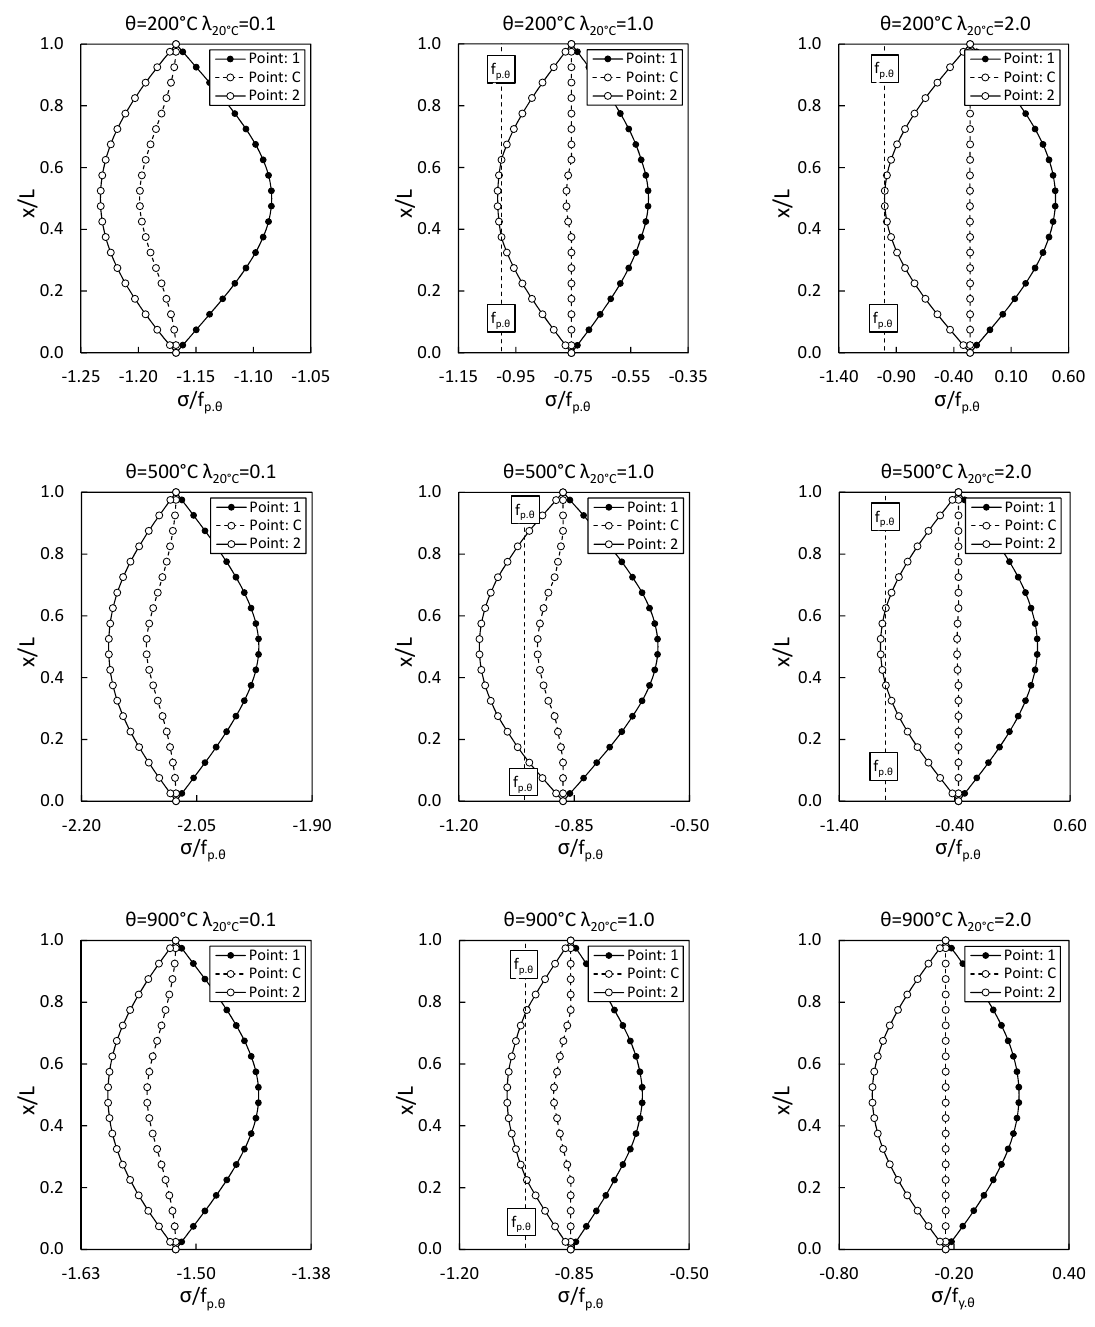
Figure 3. Stress distributions at buckling of SHS160x6 S355 for different slenderness ratios and heating temperatures. Table 2. Descriptive statistics for individual buckling factor vs. average buckling factor for the whole set.